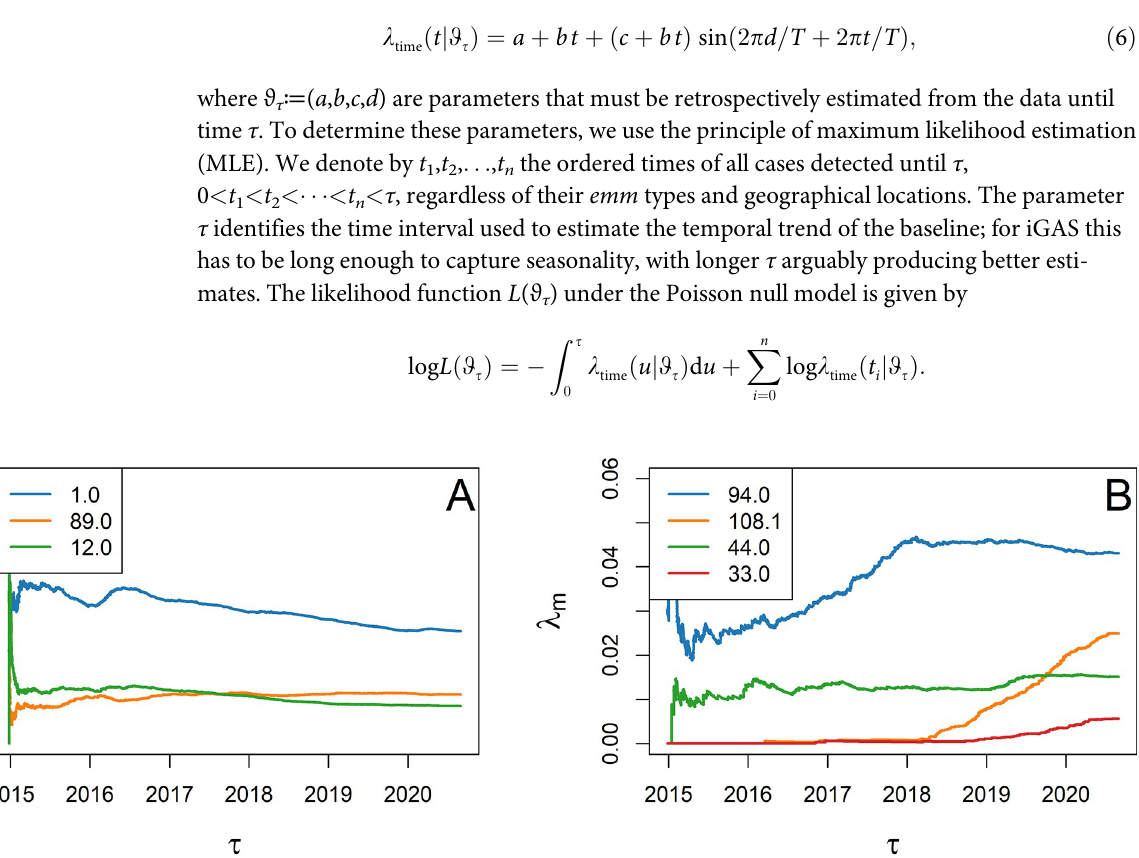
Fig 4. Relative frequency λ m of selected emm types in England computed retrospectively over the observation times τ . A The fraction the total of three most common types (viz., 1.0, 89.0, and 12.0) is either overall declining or stable, yet they still account for more than 38% of all episodes at the end of the study. B Selected emm types show concerning relative growth (108.1 and 33.0) or stable pattern (44.0 and 94.0) over recent years.